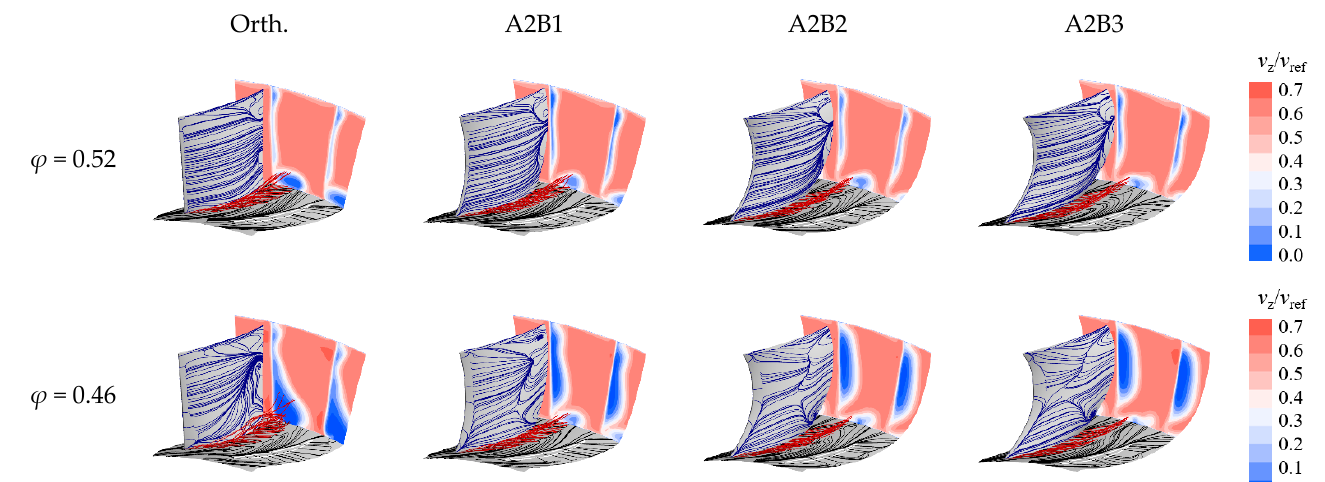
Figure 11. Flow field distribution for the cases with different sweep angles. The radial distribution of the aerodynamic parameter for the cases with different sweep angles is given in Figure 12. Results of both the φ = 0.52 and the φ = 0.46 conditions are provided. With the increase of sweep angle, the flow coefficient at the hub region increases, resulting in the improvement of the flow capacity. On the contrary, the flow capacity at the upper span parts is decreased, corresponding to the widening of the blade wake in Figure 11. The influence of the sweep angle on the radial flow of the blade is more significant at small mass flow rates. Considering the influence of the sweep angle on the corner flow and the blade separation flow, a moderate sweep angle (approximately 135° for the present study) is appropriate for the cantilevered stator. Orth.